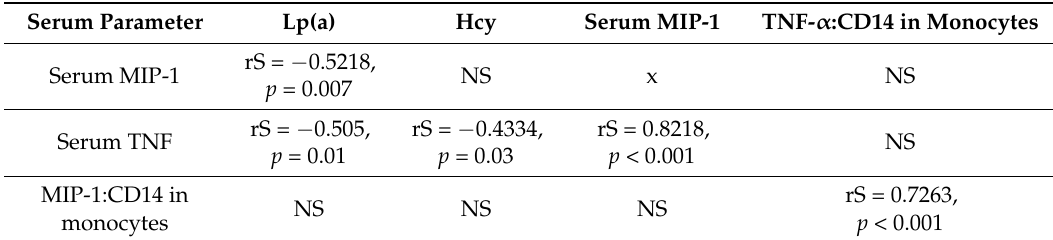
Table 6. Correlations between analyzed cytokines, chemokines, lipoprotein (a) and homocysteine in migraine patients.